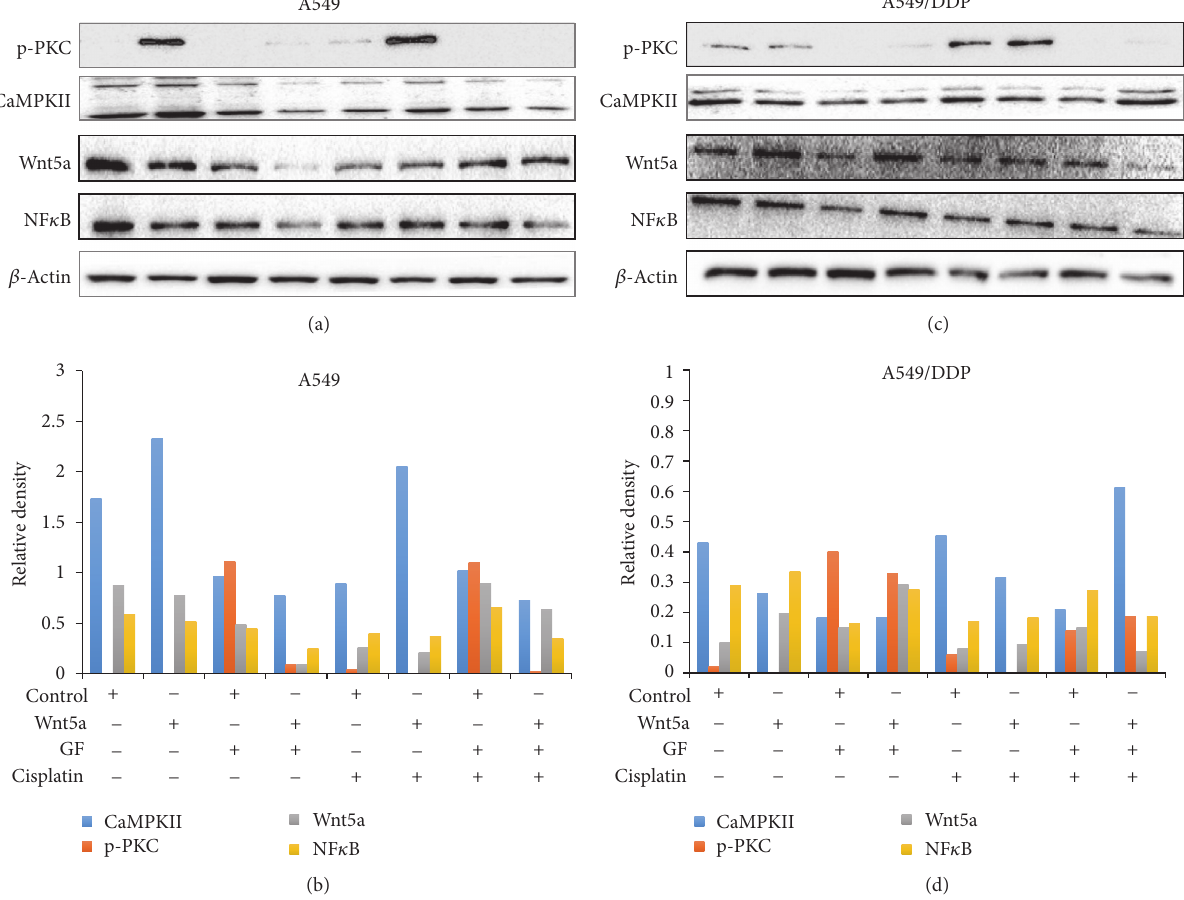
Figure 6: Wnt5a activates Wnt/calcium/PKC signaling in A549 and A549/DDP cells. A549 and A549/DDP were exposed to Wnt5a, PKC inhibitor GF109203X, and/or cisplatin during the culturing. The cells were then harvested for analyzing the expression of key components of Wnt/calcium/PKC signaling cascade. (a) Representative images of immunoblotting analysis in A549 cells. (b) The relative levels of proteins detected as evaluated by a densitometric analysis for proteins of interest of A549 cells in (a). (c) Representative images of immunoblotting analysis in A549/DDP cells. (d) The relative levels of proteins detected as evaluated by a densitometric analysis for proteins of interest of A549/DDP cells in (c). p-PKC: phosphorylated